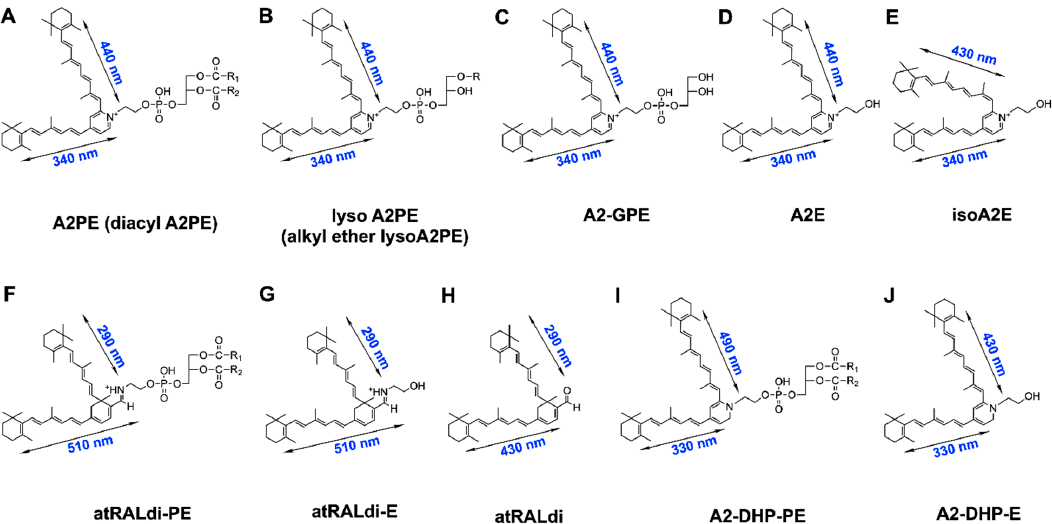
Figure 1. Structures of some of the bisretinoid fluorophores ( A – J ) known to be constituents of the lipofuscin of the retina. The fluorescence capability of bisretinoids is provided by the extensive system of carbon–carbon double bonds within the retinaldehyde-derived chromophore. Absorbance maxima ( λ max ) corresponding to the long and short arms of each bischromophore are indicated. Phosphate cleavage of A2PE generates A2E. R, R 1 , and R 2 are fatty acids with various carbon numbers and multiple double bonds. Adapted from [15] .